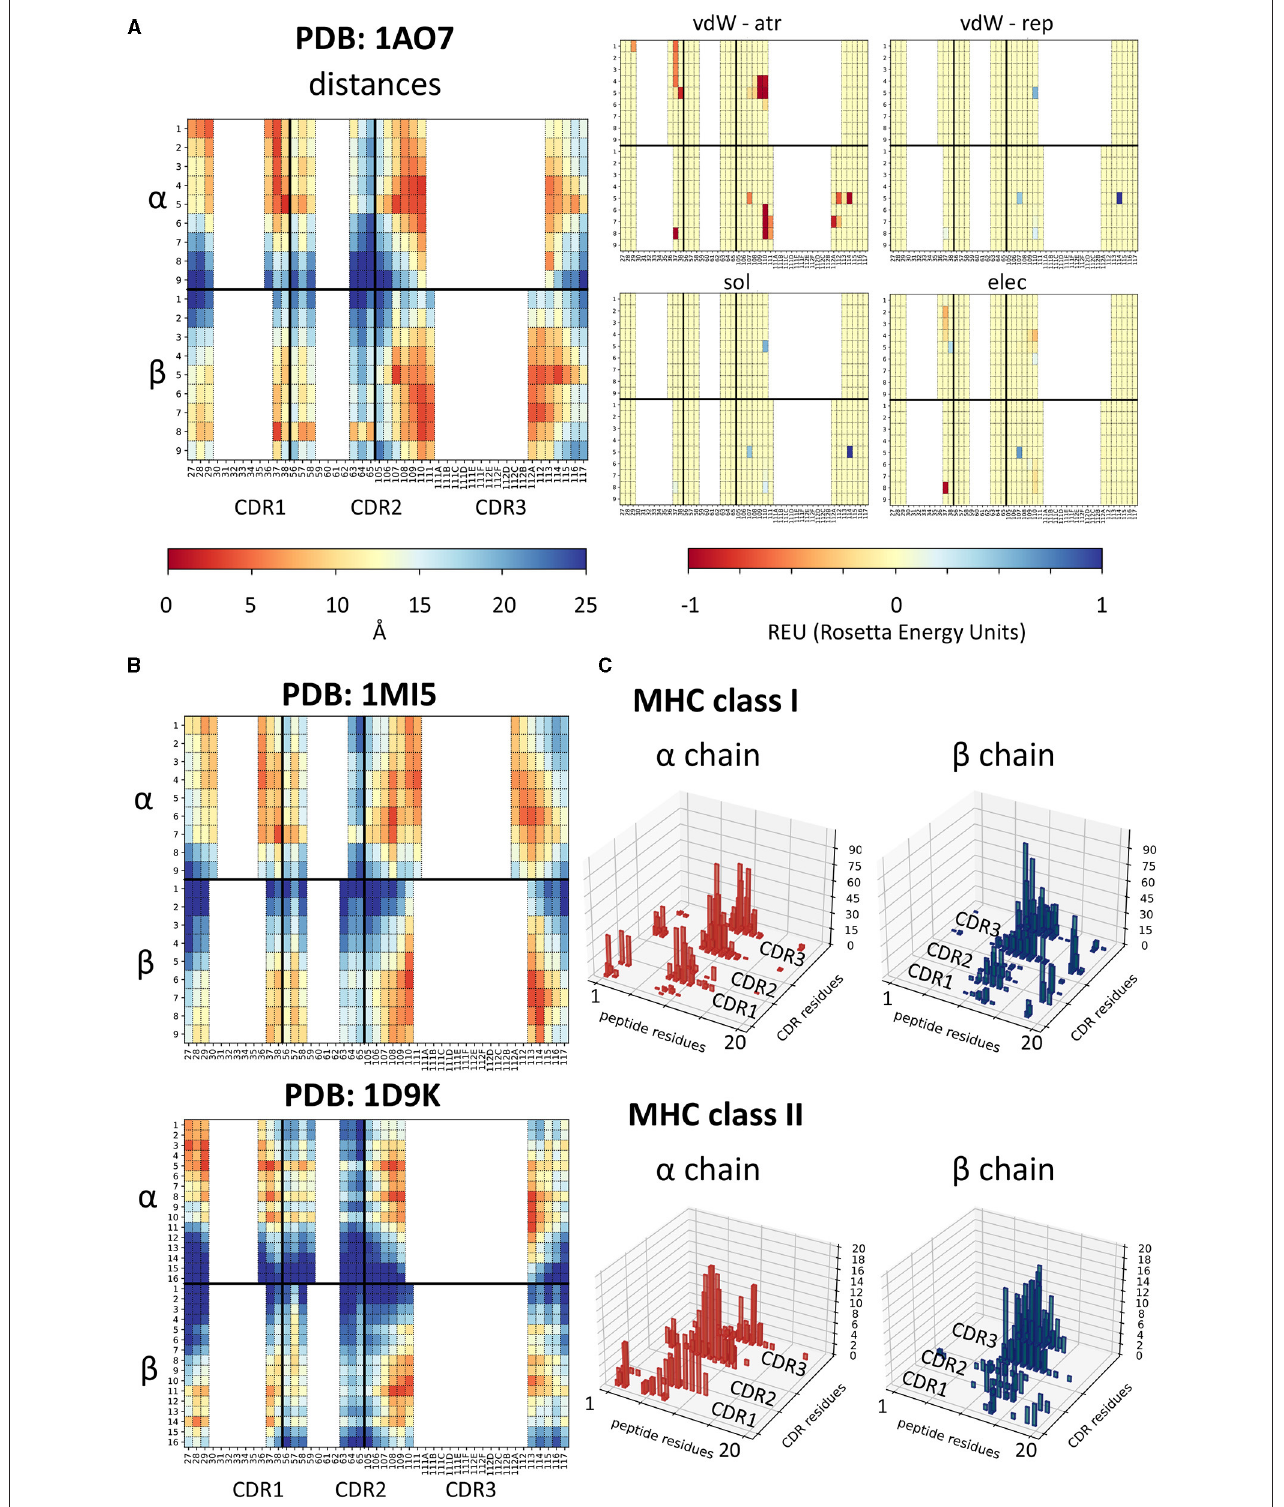
FIGURE 1 | Feature extraction from PDB structures. (A) Heatmaps showing the physical features extracted for structure 1AO7. In each heatmap, the top half refers to the α chain and the bottom half to the β chain. Each column is a CDR residue, each row is a peptide antigen residue and the colour of each square represents